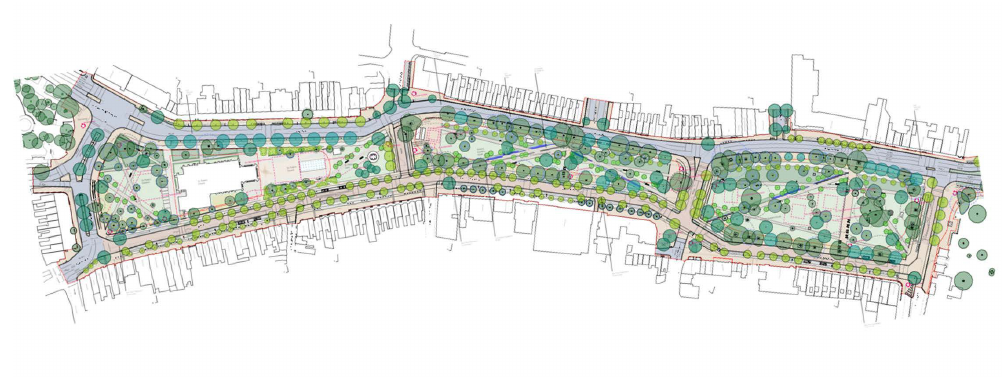
Figure 1: Layout of the redevelopment proposal (courtesy of Untitled Practice LLP and Brighton & Hove City Council) Table 1: Traflc input data used for the simulation (courtesy of Brighton & Hove City Council). All vehicles were assumed to have a speed of 32